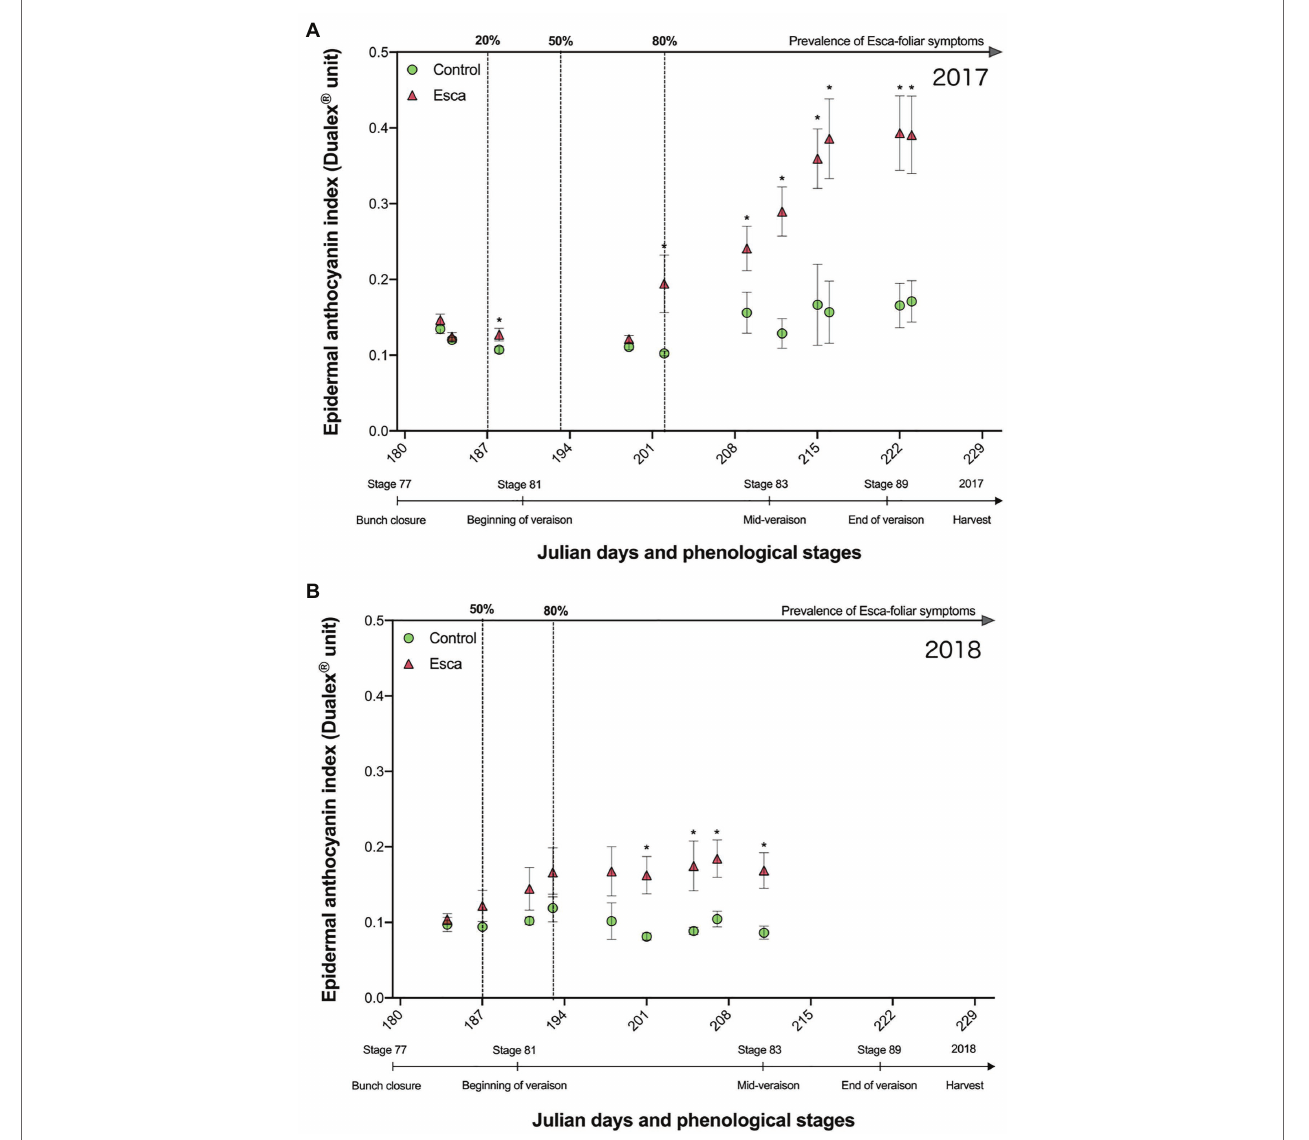
FIGURE 7 | Responses of anthocyanins in presymptomatic and Esca-symptomatic leaves in comparison with control leaves measured in 2017 (A) and in 2018 (B) . Key-growing phenological stages and the prevalence of Esca appearance are also represented below and above the horizonal axes, respectively. Error bars represent SE, and a star for a given date indicates a significant difference between asymptomatic and symptomatic grapevines at p <